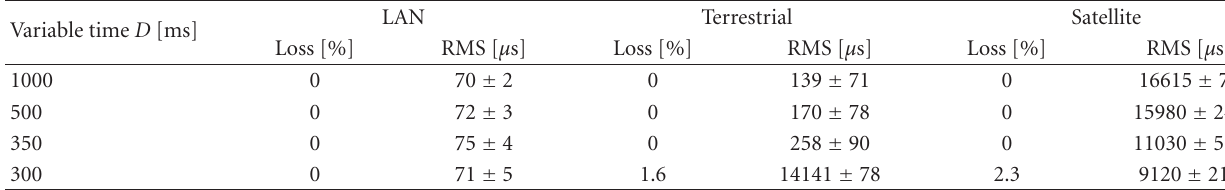
Table 1: Performance results in the presence of the LNS.